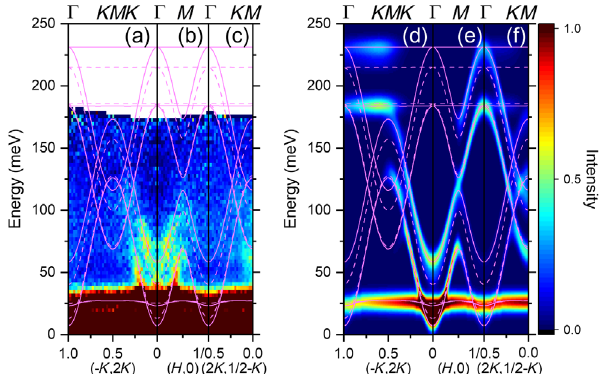
FIG. 7. Slices of the E i ¼ 250 meV data after averaging over Δ L ¼ (cid:4) 7 showing the dispersion along the (a) ð − K; 2 K; 0 Þ , (b) ð H; 0 Þ , and (c) ð 2 K; 1 = 2 − K Þ directions. For all panels, the data are additionally averaged over either Δ H ¼ (cid:4) 0 . 1 or Δ K ¼ (cid:4) 0 . 058 . (d) – (f) Model calculations of the neutron inten- sities with the same reciprocal space averaging of the data as in (a) – (c) and convolved with a Gaussian energy FWHM of 12 meV. In all panels, pink lines correspond to model dispersions with L ¼ 0 (solid lines) and L ¼ 0 . 5 (dashed